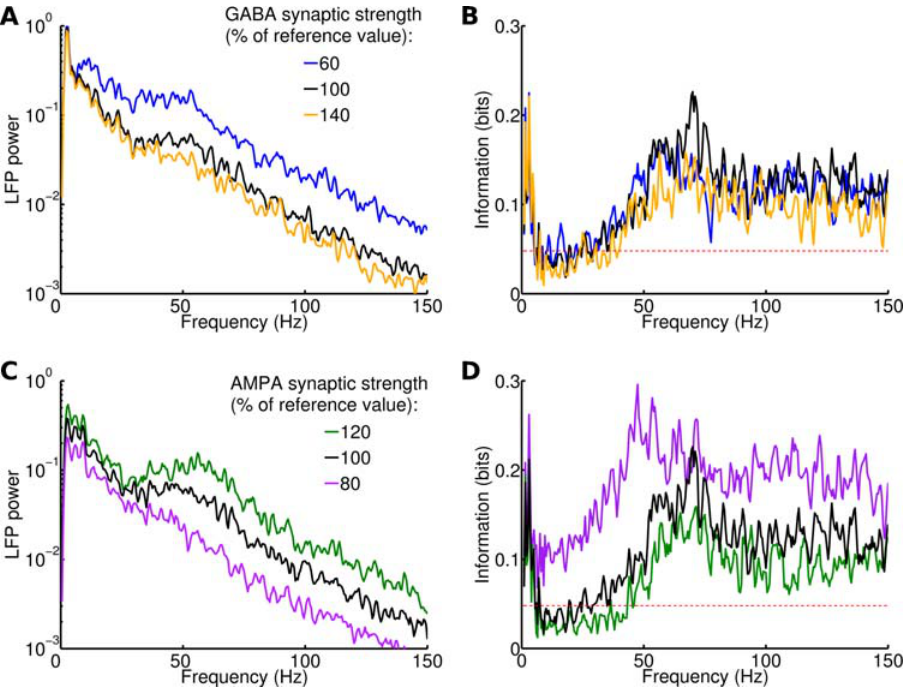
Figure 10. Effects of modulations in GABA and AMPA synaptic strength when naturalistic stimuli are injected. (A) Power spectrum of LFP for a single stimulus and different values of GABA strength, measured as percentage of the reference strength displayed in Table 2. Results are averaged over 20 trials. (B) Information contained in the LFP spectrum for the three synaptic strengths. Red dashed line corresponds to significance threshold (p , 0.05; bootstrap test) for information. Same color code as (A). (C–D) Same as (A–B) for AMPA strength modulations.